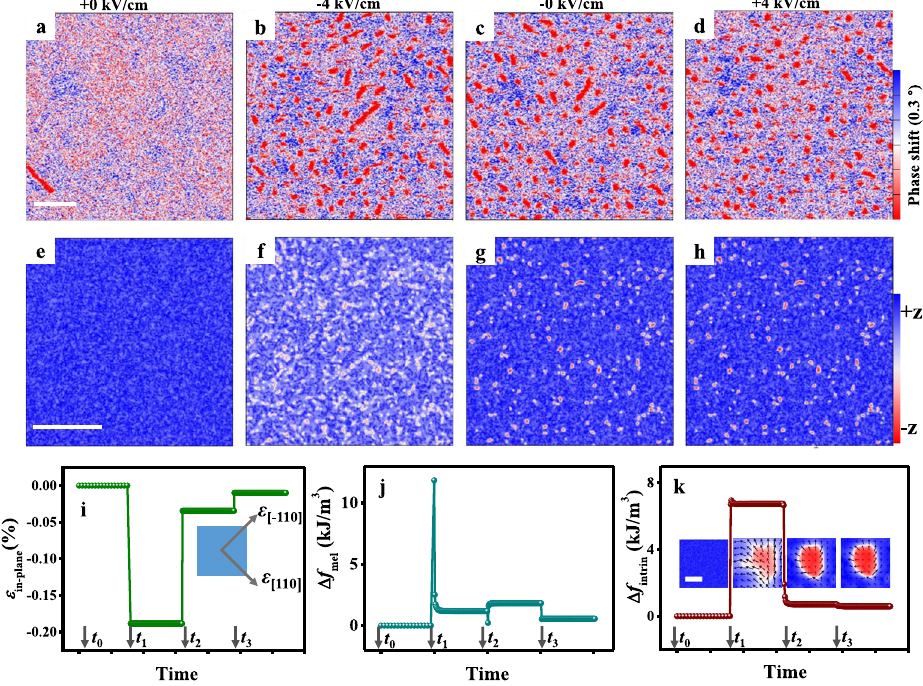
Fig. 3 Skyrmion creation. MFM images at E = + 0 kV/cm ( a ), − 4 kV/cm ( b ), − 0 kV/cm ( c ), and + 4 kV/cm ( d ) with B bias = 60 mT. Corresponding simulation results of strain-mediated skyrmion creation with ε 110 ½ (cid:2) ¼ ε (cid:3) 110 ½ (cid:2) ¼ 0 (initial state) and D = 0.772 mJ/m 2 ( e ), ε 110 ½ (cid:2) ¼ ε (cid:3) 110 ½ (cid:2) ¼ (cid:3) 0 : 189 % and D = 0.585 mJ/m 2 ( f ), ε ¼ ε ¼ (cid:3) 0 : 034 % and D = 0.685 mJ/m 2 ( g ), and ε ¼ ε ¼ (cid:3) 0 : 010 % and D = 0.727 mJ/m 2 ( h ), with the blue and (cid:3) 110 ½ (cid:2) (cid:3) 110 ½ (cid:2) 110 ½ (cid:2) 110 ½ (cid:2) red contrasts corresponding to magnetizations pointing up and down, respectively. The scale bar is 1 μ m. Evolutions of in-plane biaxial compressive strain ε ¼ ε ¼ ε f f (cid:3) 110 ½ (cid:2) ( i ), magnetoelastic energy density mel ( j ), and intrinsic energy density intrin ( k ). The time stages are in (cid:3) plane 110 ½ (cid:2) − 4 kV/cm), t E = − 0 kV/cm), and t E = + 4 kV/cm), respectively. The insets of k are the corresponding individual skyrmion evolutions with a scale 2 ( 3 ( bar of 50